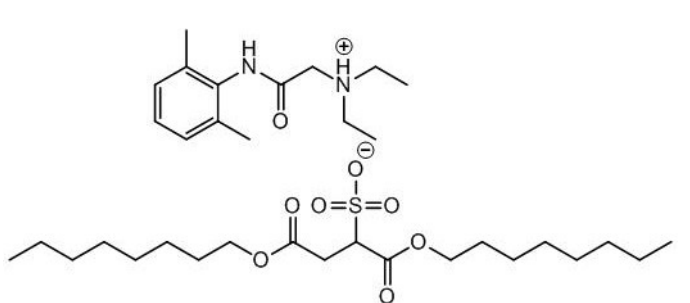
Figure 3. Lidocaine docusate IL.